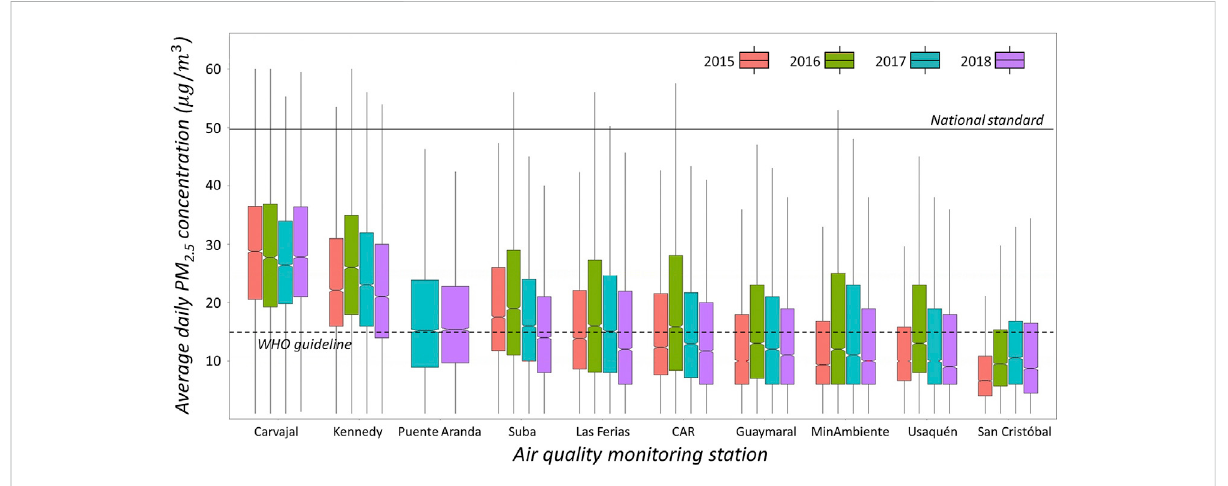
FIGURE 2 Boxplots of average daily PM 2.5 concentration measured at the RMCAB monitoring stations, from 2015 to